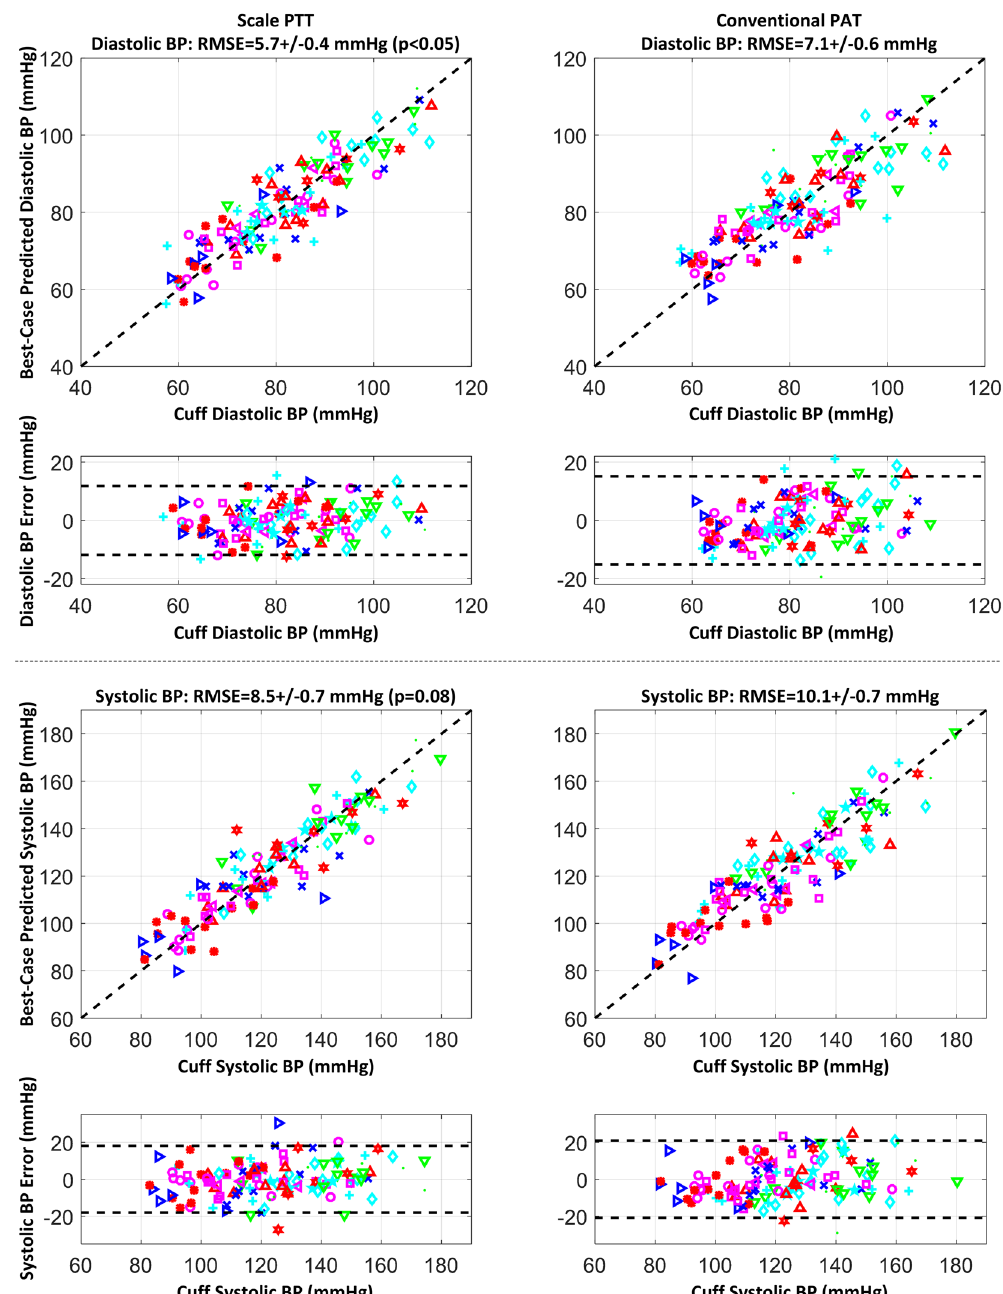
Figure 1. Correlation plots of predicted BP via scale PTT and via conventional PAT after best-case calibration for each time delay versus cuff BP and Bland-Altman plots of the errors between the predicted and measured BP versus cuff BP pooled over all the subjects, along with the group average RMSEs. The different symbols correspond to each of the subjects. Scale PTT yielded lower diastolic and systolic BP RMSEs than conventional